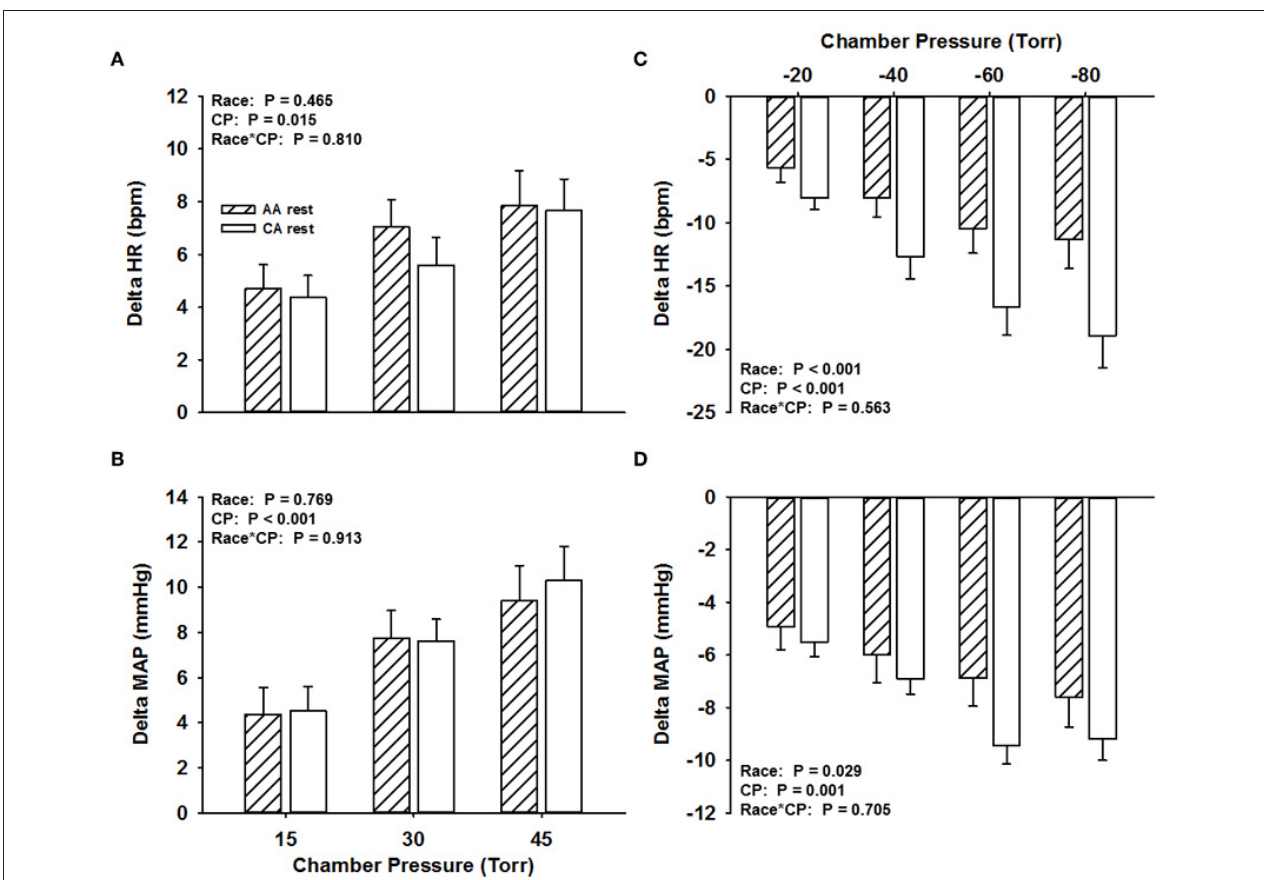
FIGURE 1 | Change in HR (A) and MAP (B) in response to NP and change in HR (C) and MAP (D) in response to NS in African Americans (AA, hatched bars) and Caucasian Americans (CA, open bars) at rest. CP, chamber pressure.